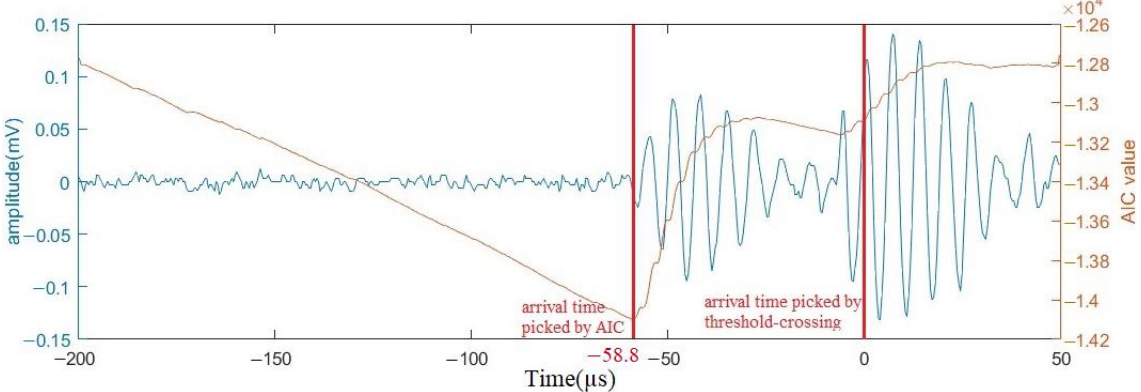
Figure 10. Determination of arrival time by the AIC method; threshold-crossing prediction is indi- cated as time = 0.